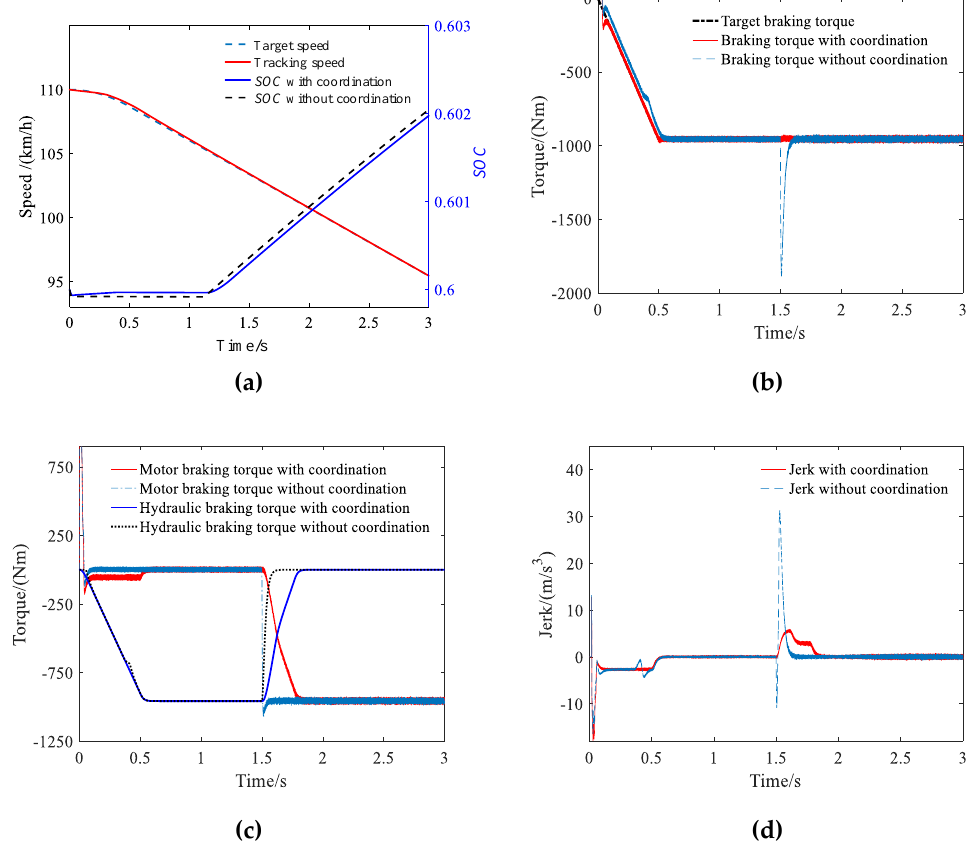
Figure 13. Simulation results of the pure hydraulic switch to a pure motor braking mode under a constant braking strength: ( a ) The variation in vehicle speed and SOC , ( b ) the variation in total braking torque, ( c ) the variation in motor and hydraulic braking torque, and ( d ) the variation in vehicle jerk.